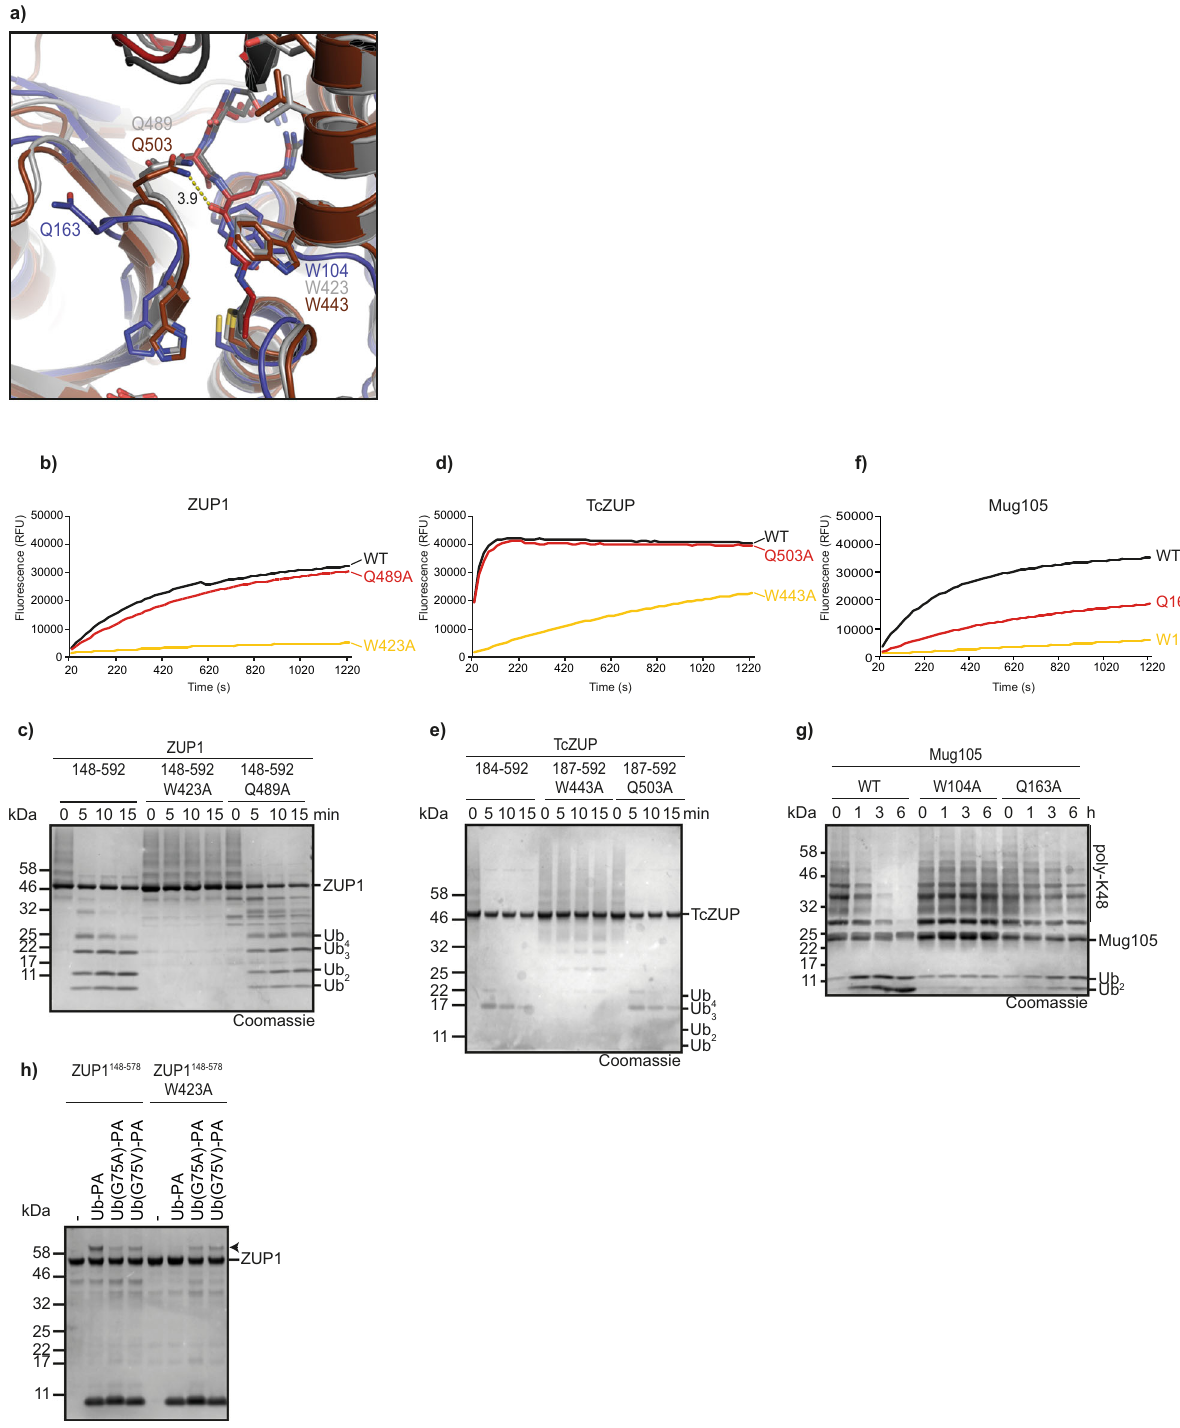
Fig. 5 Ubiquitin-binding induced conformational changes. a Structural superposition of ubiquitin-bound TcZUP (brown) and ZUP1 (6EI1, gray) with ubiquitin-less Mug105 (blue). The catalytic core is shown in carton representation and key residues are highlighted as sticks. C-terminal residues of ubiquitin are shown as sticks and colored red and dark gray. Trp-104 and Gln-163 exhibit different conformations compared to the corresponding residues of ZUP1 and TcZUP. b , c Activity of ZUP1 148 – 578 W423A or Q489A against RLRGG-AMC (b) or K63-linked Ub 6 + chains ( c ). d , e Activity of TcZUP 187 – 592 W443A or Q503A against RLRGG-AMC ( d ) or K63-linked Ub 6 + chains ( e ). f , g Activity of Mug105 W104A or Q163A against RLRGG-AMC ( f ) or K48- linked ubiquitin chains ( g ). h Activity-based probe reaction of wildtype or W423A-mutated ZUP1 148 – 578 with Ub-PA. Both DUBs were tested against WT, G75A, or G75V Ub-PA. Black arrowheads mark the shifted band after reaction. Source data are provided as a Source Data fi